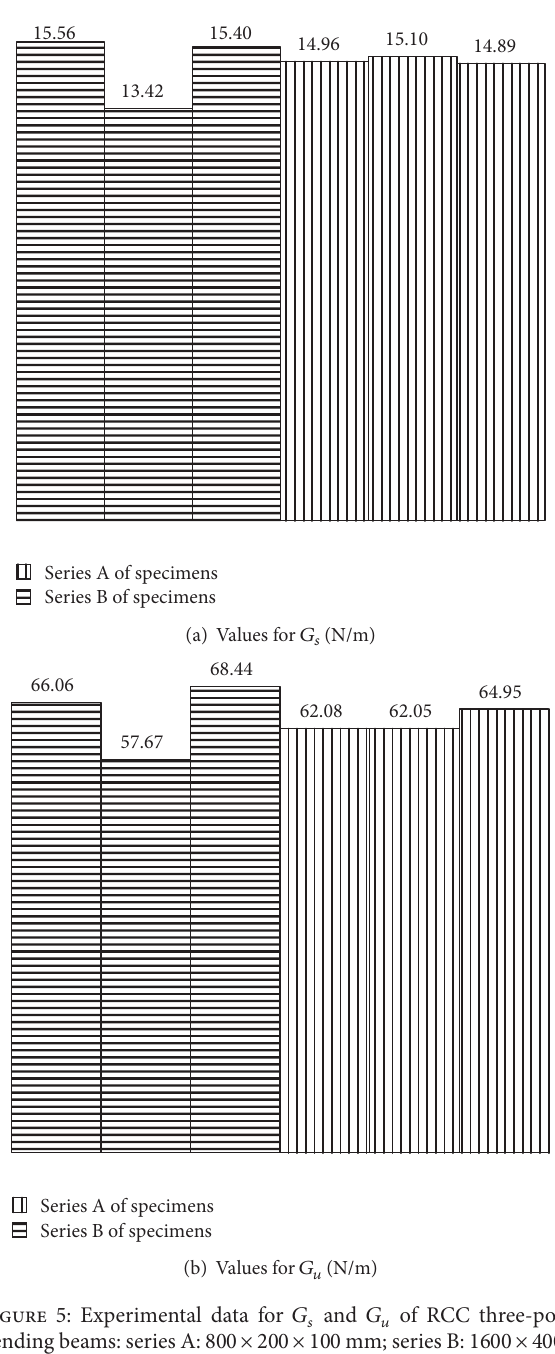
Figure 5: Experimental data for 𝐺 𝑠 and 𝐺 𝑢 of RCC three-point bending beams: series A: 800×200×100 mm; series B: 1600×400× 200